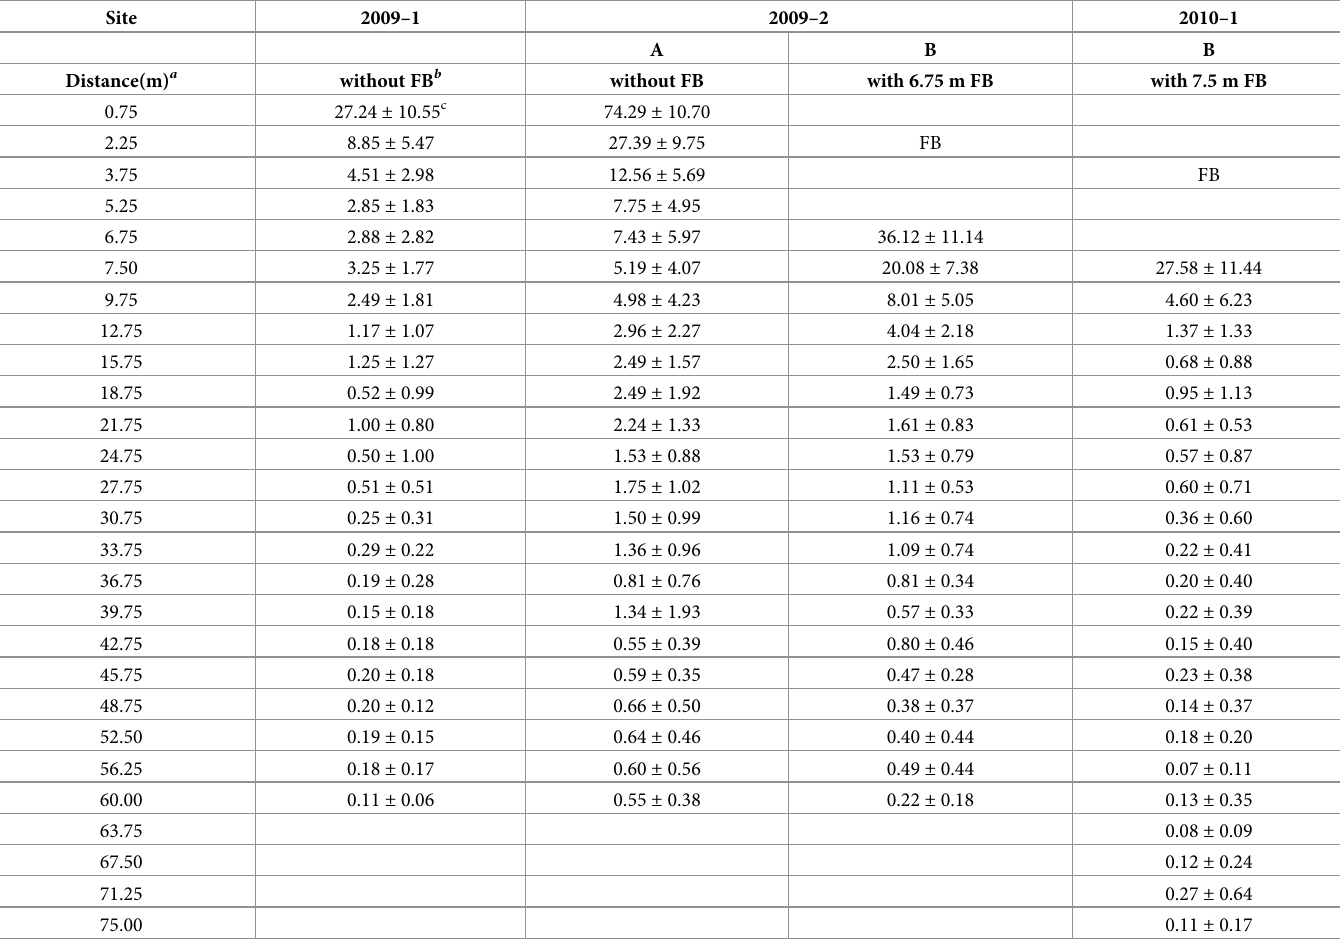
Table 1. Average CP rate (%) in various rows and the distances from the pollen source in the 2009–1, 2009–2, and 2010–1 fields. Site